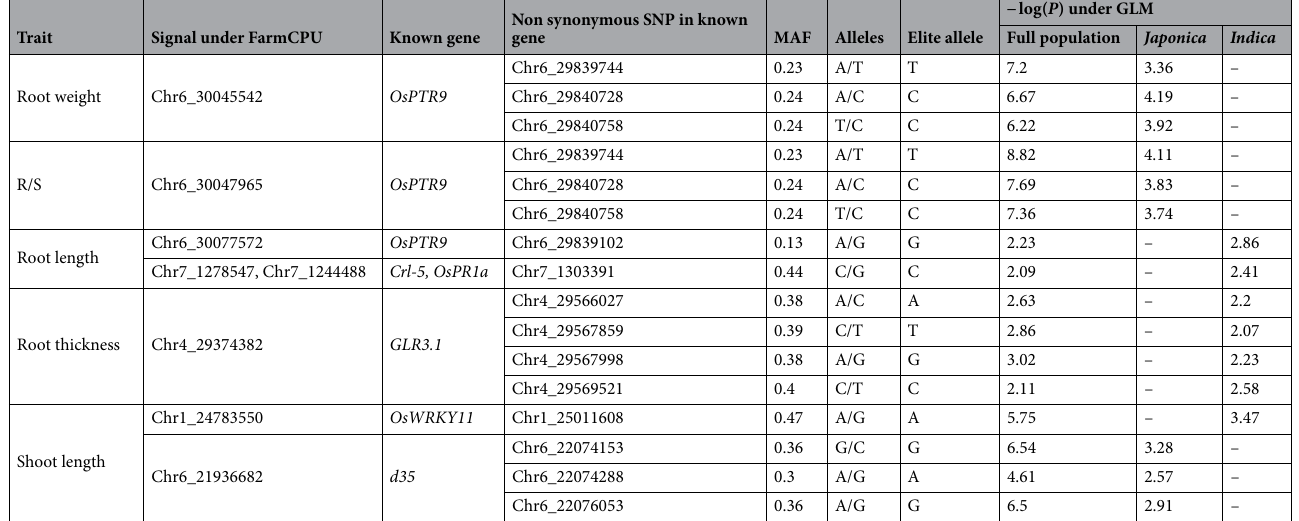
Table 2. Summary of 13 possible functional SNPs within five known